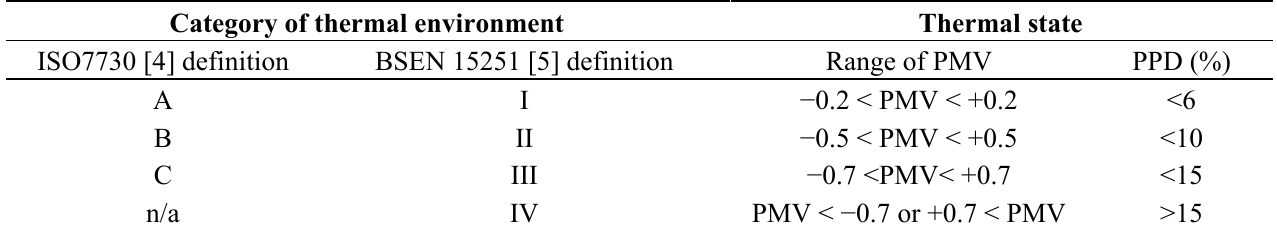
Table 1. Building categorizations used in comfort